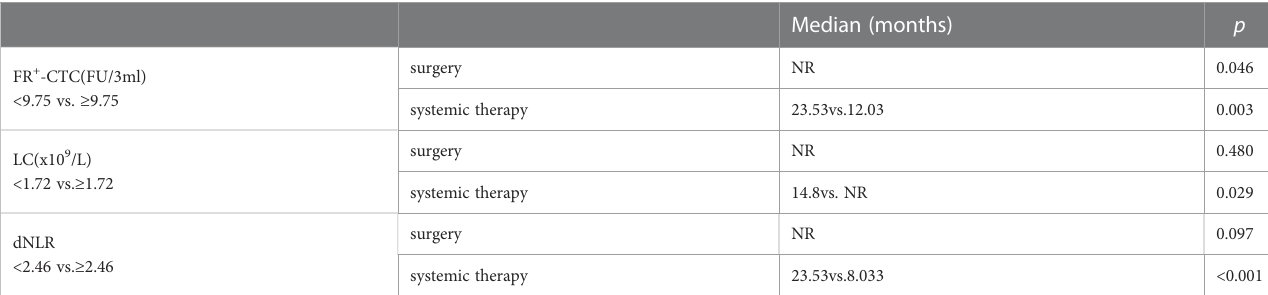
TABLE 4A Survival probability according to the FR + -CTC count, LC and dNLR between surgery and systemic therapy.